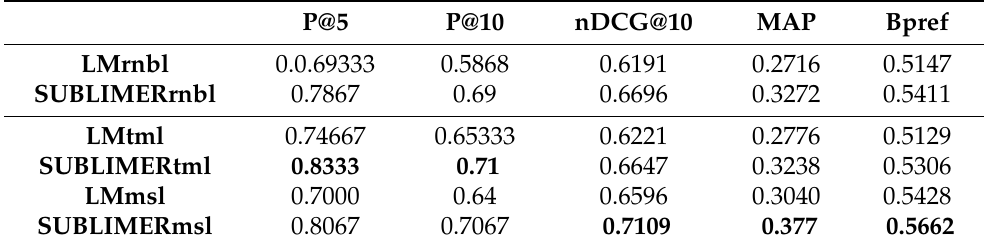
Table 1. The table compares results from the model trained with triplet loss function tml and the one trained using the multi similarity loss msl. We also add the model’s results trained using the triplet loss function, but using random negatives instead of one selected by using bibliography (rnbl). We compare the language model LM but also the entire informational retrieval SUBLIMER